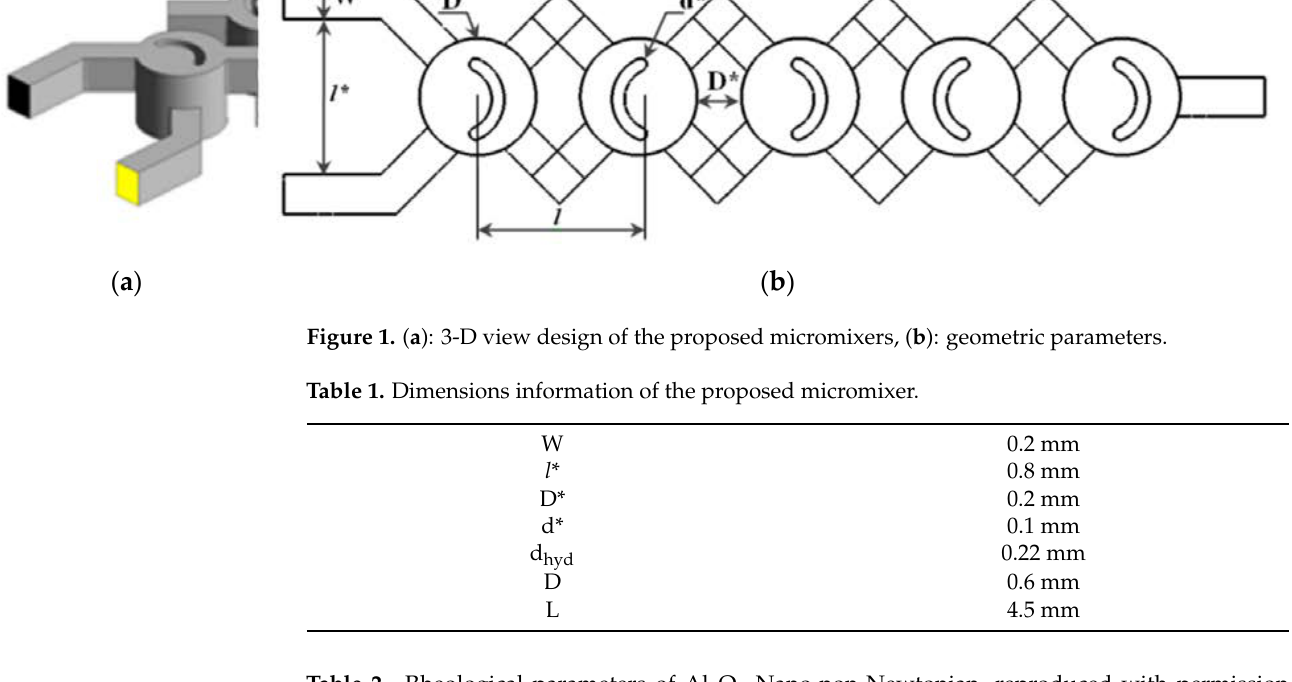
Table 2. Rheological parameters of Al 2 O 3 Nano-non-Newtonian, reproduced with permission from [23,24].